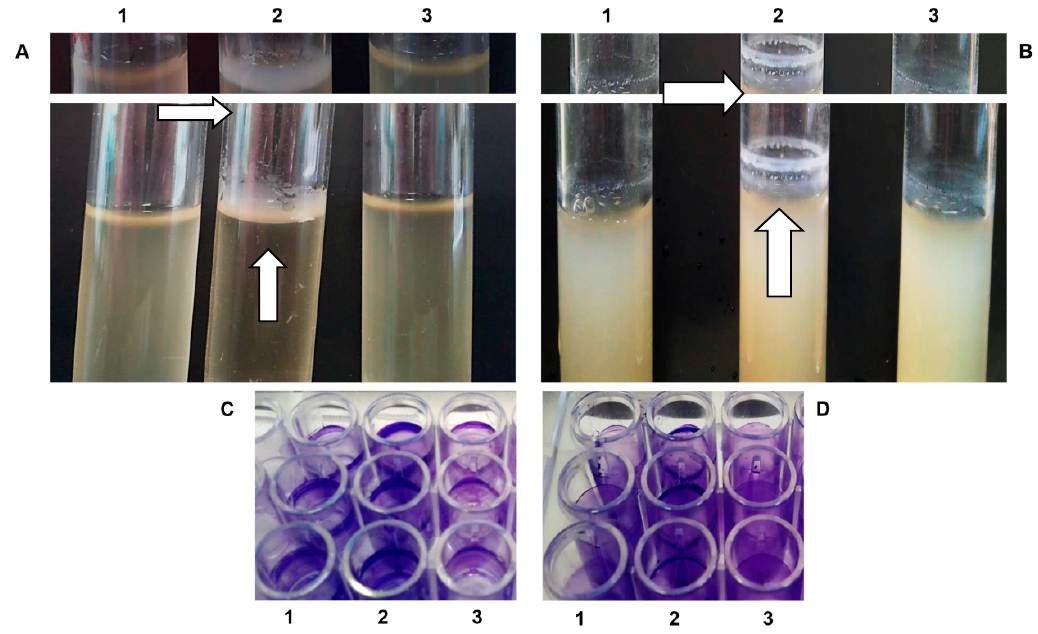
Figure 3. Pellicle and ring-like structure formation by ONT:H25, HFC01 and HFC02. ( A ) Pellicle formation on air-liquid interface in 24 h at 37 °C in LB, arrows indicate pellicle and ring-like structure formation; ( B ) Ring-like structure formation on air-liquid-glass interface in 72 h at 37 °C in LB, arrows indicate pellicle and ring-like structure formation; ( C ) Ring-like structure formation in 96-well plate after 72 h at 26 °C. 1 , ONT:H25; 2 , HFC01; 3 , HFC02. ( D ) Ring-like structure formation in 96-well plate after 72 h at 37 °C in LB. 1 , ONT:H25; 2 , HFC01; 3 , HFC02.